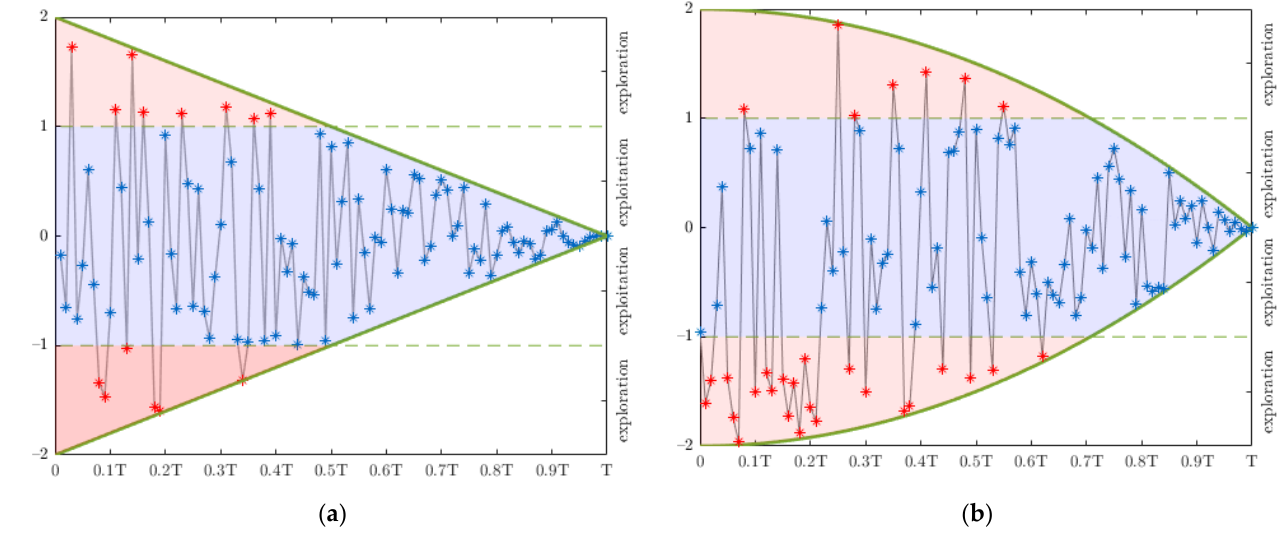
Figure 3. Changes of the a parameter in ( a ) the classical GWO, ( b ) the modified GWO. The distance between the three best points ( X α , X β , and X δ ) and the solution candidate can be calculated using Equations (39)–(41).